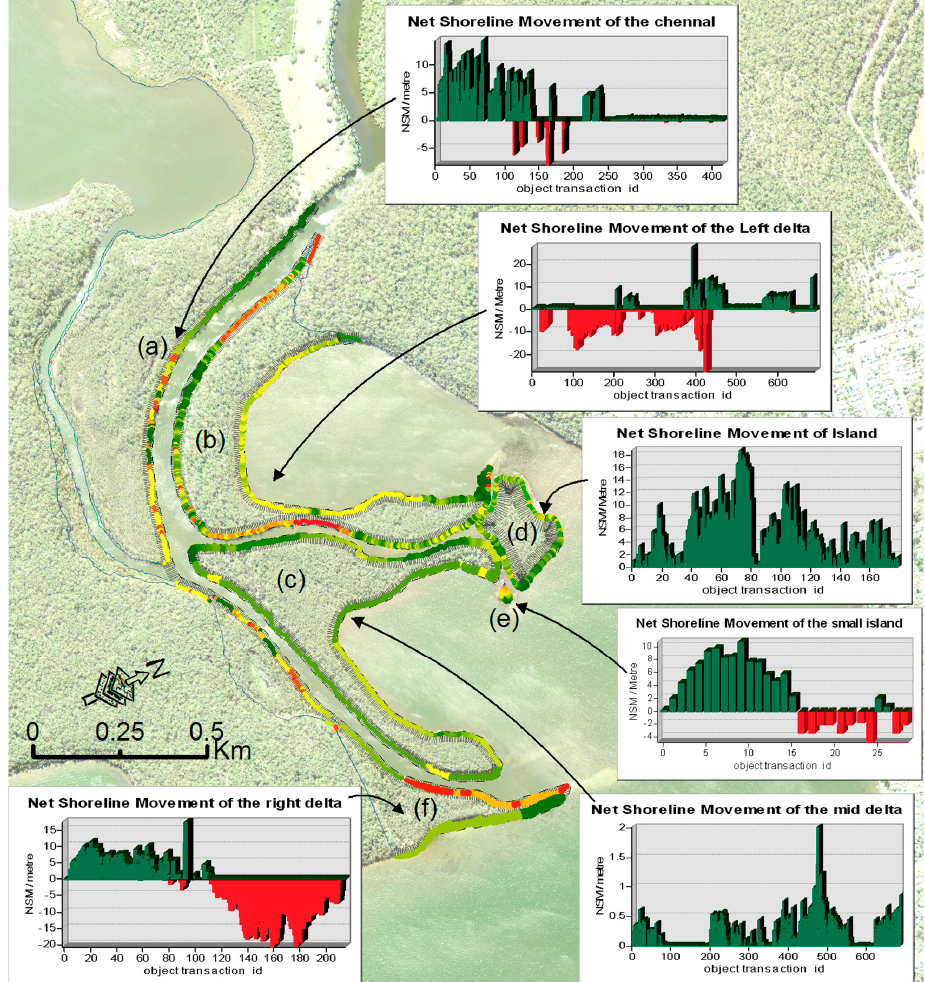
Figure 10. Digital shoreline analysis system (DSAS) applied to the sensitive Wandandian Delta shows shoreline erosion in red, accretion in green while yellow represents the stable zones. Attached charts show the net shoreline movement envelope between 1949 and 2016: ( a ) the upper channel; ( b ) western portion of the delta; ( c ) the mid delta; ( d ) large interdistributary island; ( e ) small mouthbar island; and ( f ) eastern portion of the delta.